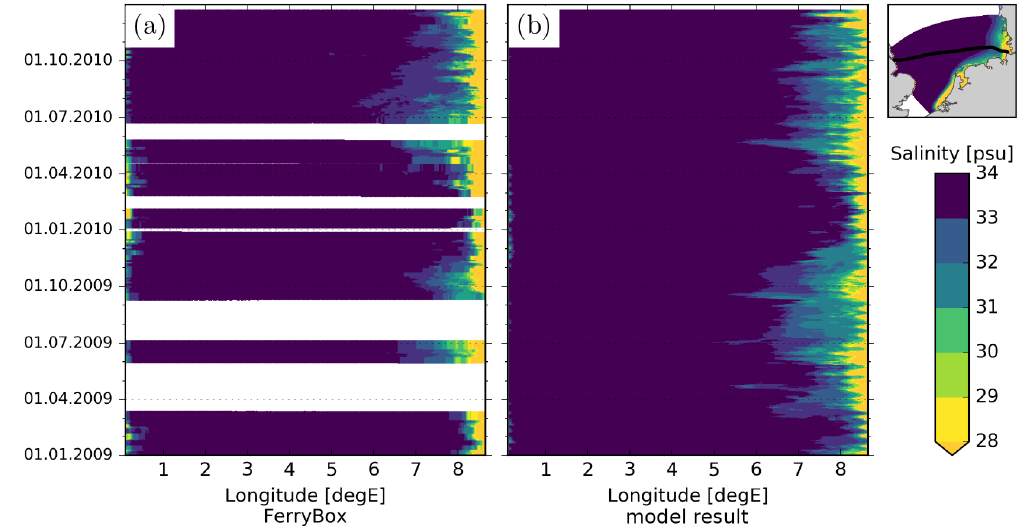
Figure 3. Salinity (PSU) measured by FerryBox (a) and estimated by the model (b) along the route shown in the inset. Note that the lower range of salinity was